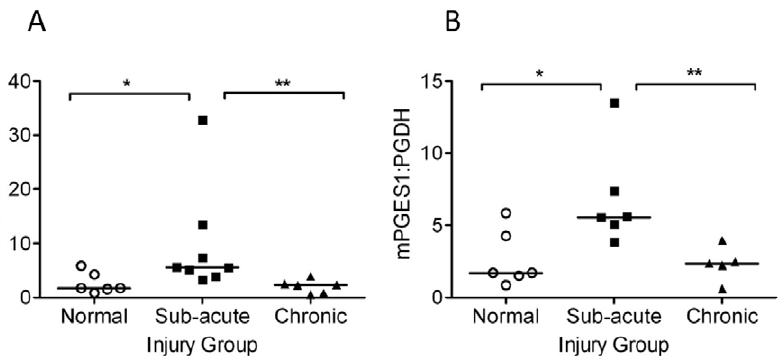
Figure 4. mPGES-1 and PGDH expression in normal and injured tendons. mPGES-1 and PGDH mRNA expression were normalised to GAPDH or 18S ribosomal RNA and are shown expressed as mPGES-1: PDGH ratio in each case. (A) Median values for GAPDH normalized ratio of mPGES-1: PGDH gene expression in normal (n=6), sub-acute (n=8) and chronic injured flexor tendons (n=6). (B) Median values for 18S normalized ratio of mPGES-1: PGDH gene expression in normal (n=6), sub-acute (n=6) and chronic injured flexor tendons (n=5), showing elevated mPGES-1:PGDH expression in sub-acute injury compared to normal and chronic injured tendons.